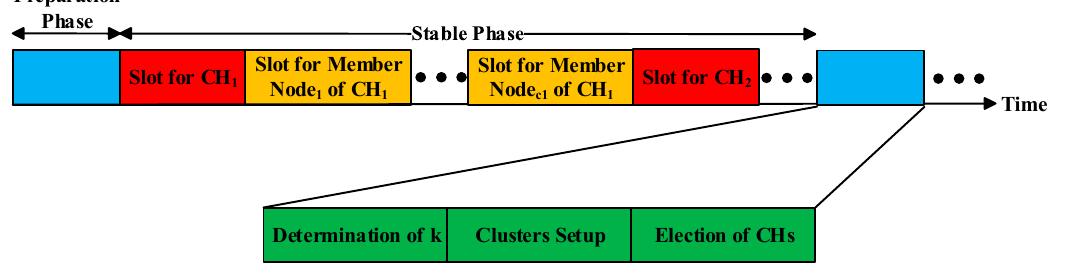
Figure 4. The time slot allocation of the clustering protocol.